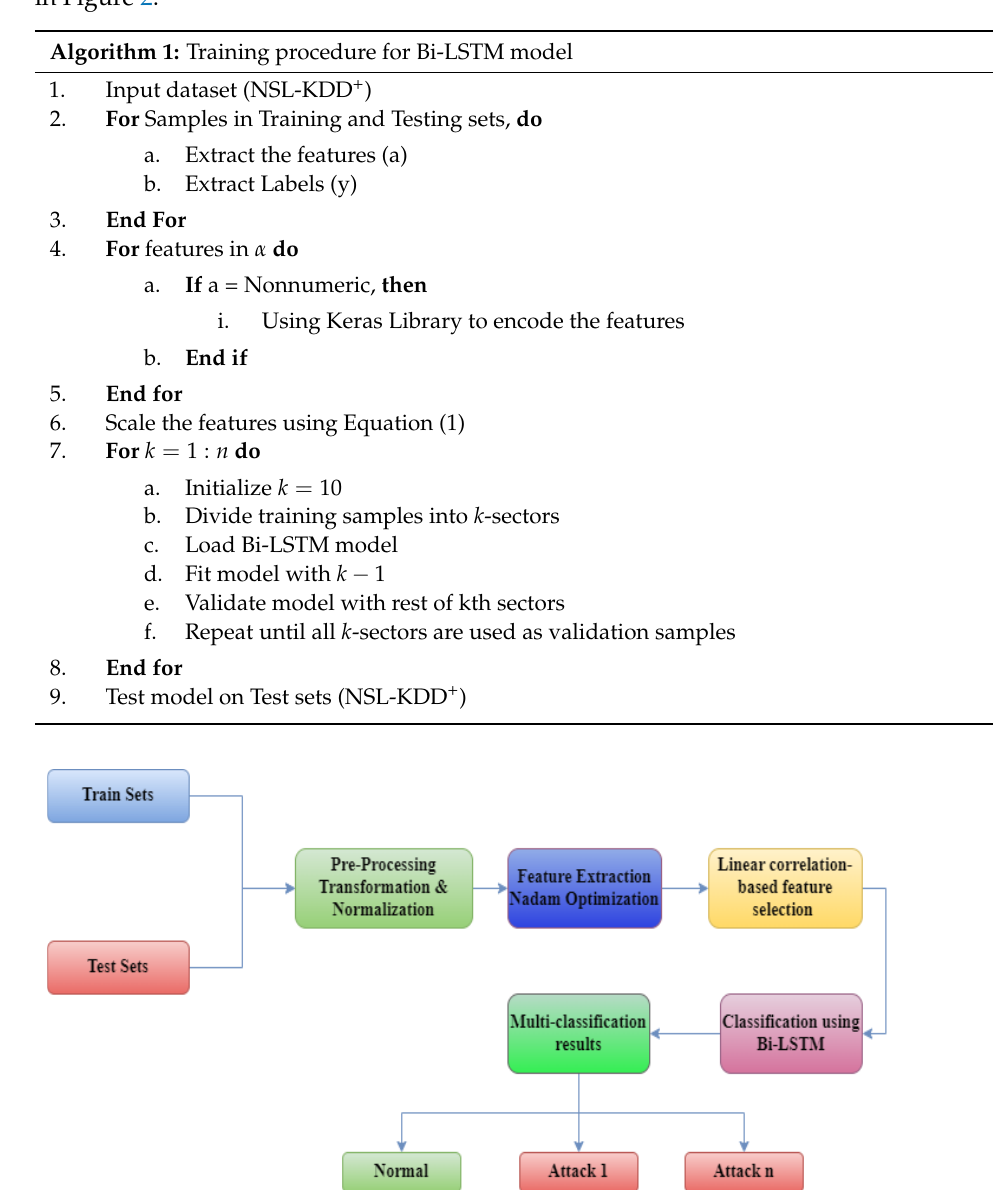
Algorithm 1: Training procedure for Bi-LSTM model